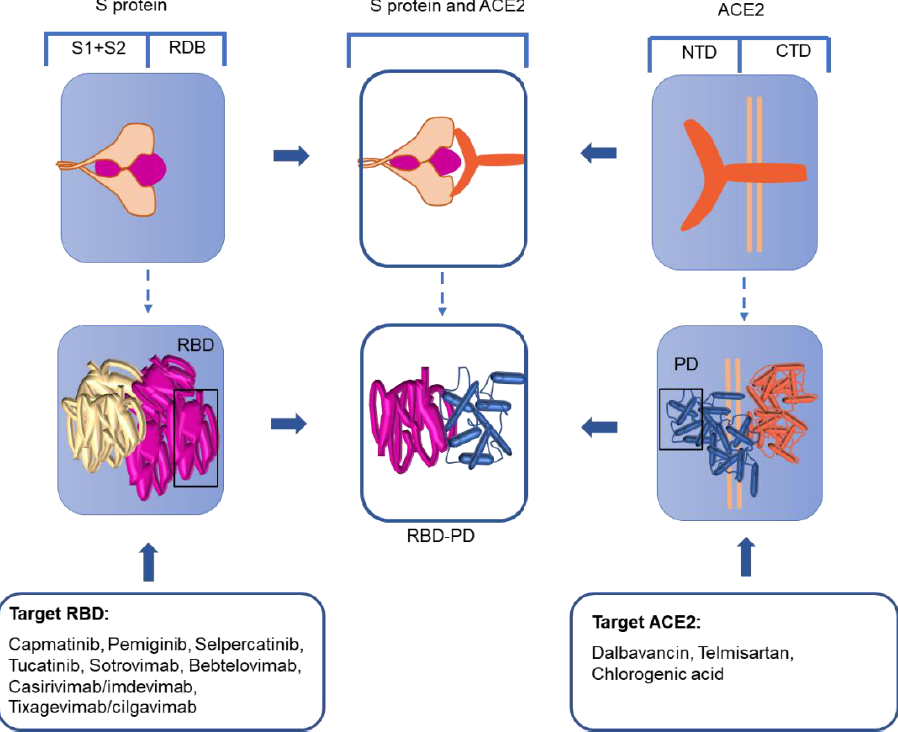
Figure 3. S protein and RBD process. S protein: spike protein; RBD: receptor-binding domain; ACE2: angiotensin-converting enzyme 2; PD: protease domain; NTD: N-terminal domain; CTD: C-terminal domain.